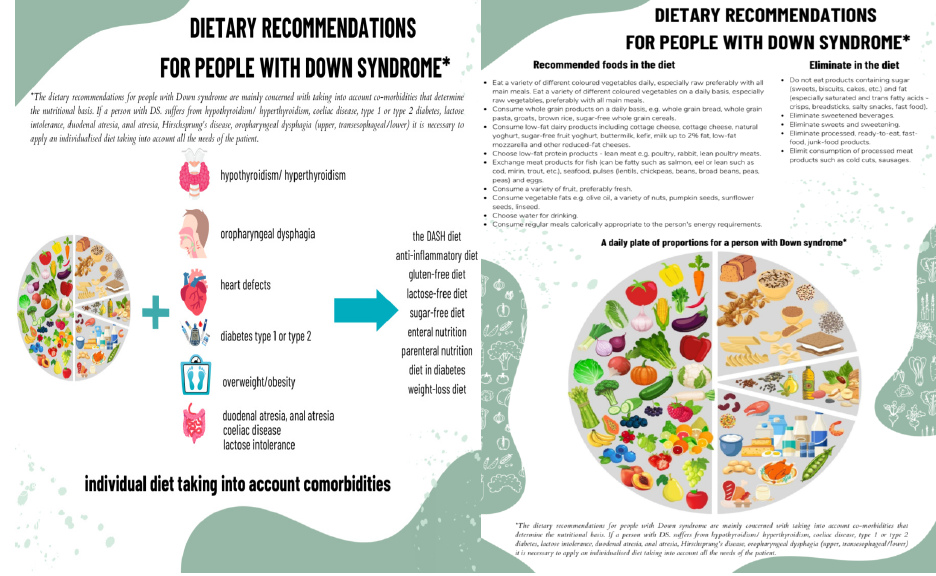
Figure A1 Dietary recommendations for people with down syndrome Figure A1. Dietary recommendations for people with down